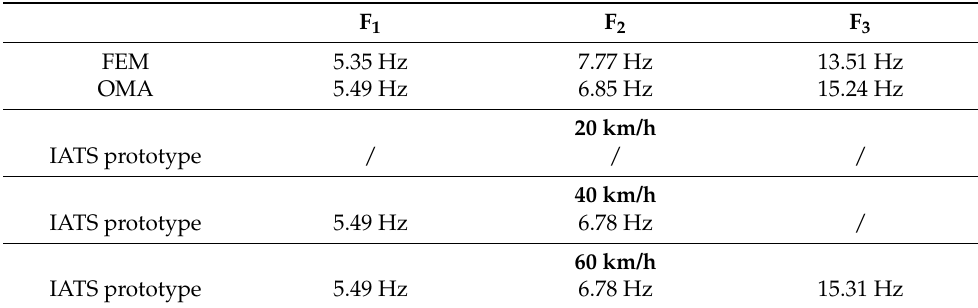
Figure 10. Amplitude spectrum of vertical component obtained from IATS prototype measurements: ( a ) excitation by train passing at 20 km/h — no frequency was detected; ( b ) excitation by train passing at 40 km/h — first and second frequency were detected; ( c ) excitation by train passing at 60 km/h — first, second, and third frequency were detected. Table 4. Computed natural frequencies using FEM, obtained by OMA and determined from IATS prototype measurements during bridge dynamic load